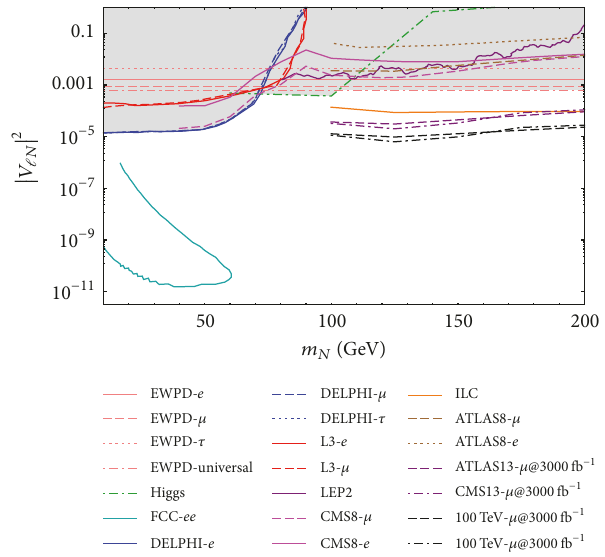
Figure 25: Bounds on the square of the mixing angle from the same-sign dilepton plus di-jet final state as a function of the heavy neutrino mass (𝑚 𝑁 ) . The shaded region is ruled out by DELPHI, EWPD, and Higgs data. Prospective bounds from the Higgs data had been calculated in [45] for the LHC at the high luminosity (3000 fb −1 ) and future 100 TeV pp collider.